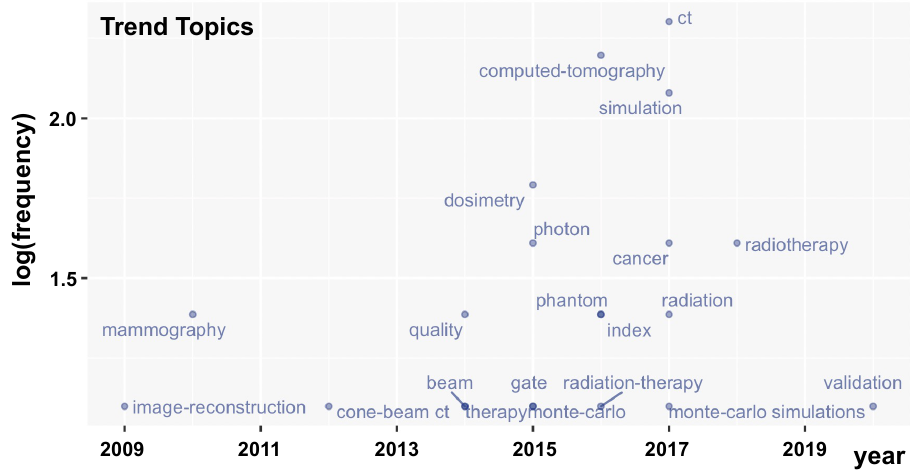
Figure 4. Trending topics between 2008 to